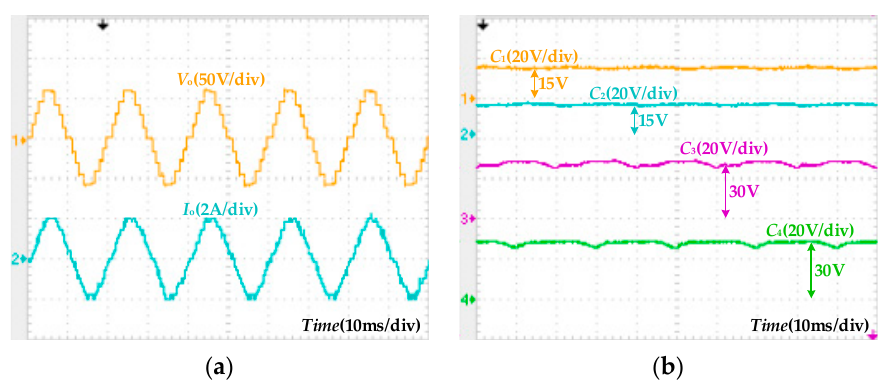
Figure 17. Experimental waveforms. ( a ) Output voltage and current. ( b ) Capacitor voltages.